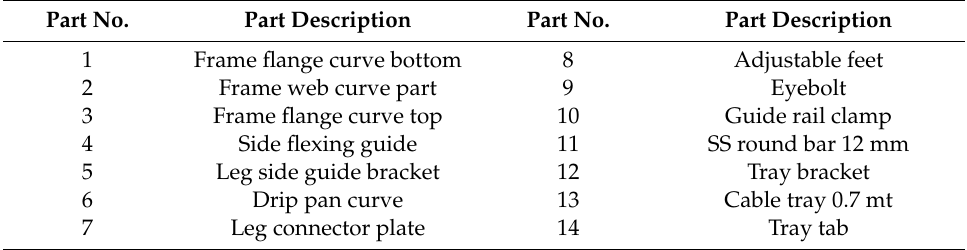
Figure 15. Exploded diagram for ‘Curve section new’. Table 6. Part description for ‘Curve section new’.